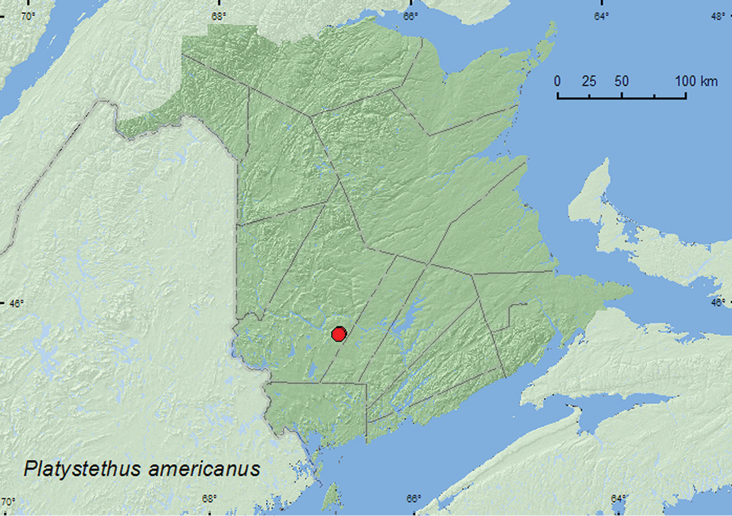
Collection localities in New Brunswick, Canada of Platystethus americanu